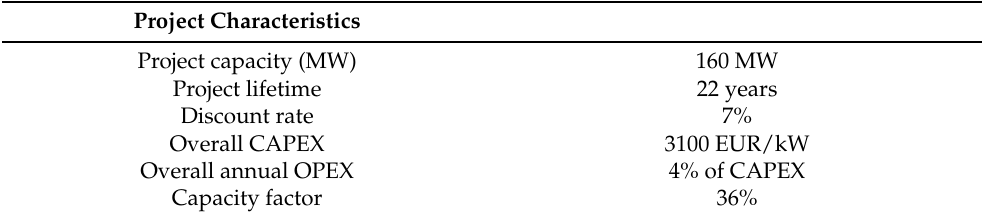
Table 3. Typical features and costs of a generic, utility-scale floating wave energy farm gathered from a survey sent to many developers around the world [51]. Data adapted from [51].